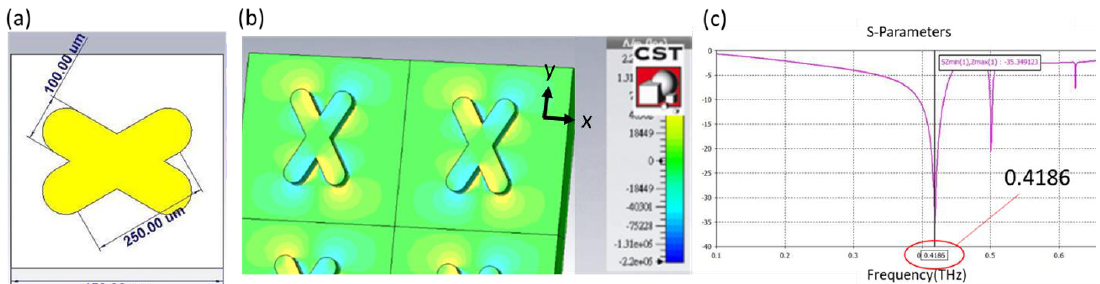
Figure 1. ( a ) Scale of an XPS, of linewidth 100 µ m, length 250 µ m and period 450 µ m. ( b ) x-component of electric field distribution in a quadrupole resonance. ( c ) A simulation result shows a resonant dip at frequency 0.4186 THz.